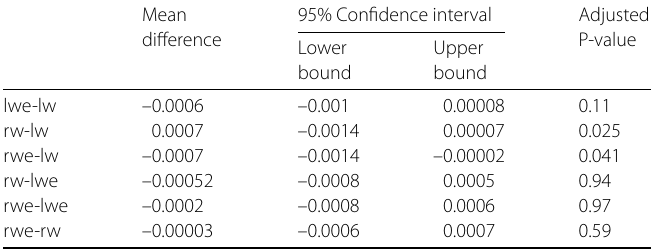
Table A9 Multi-group mean comparisons of ingroup loyalty in 25% sample size data using Tukey’s HSD test Mean 95% Confidence interval Adjusted difference P-valueLower Upper bound bound lwe-lw –0.0006 –0.001 0.00008